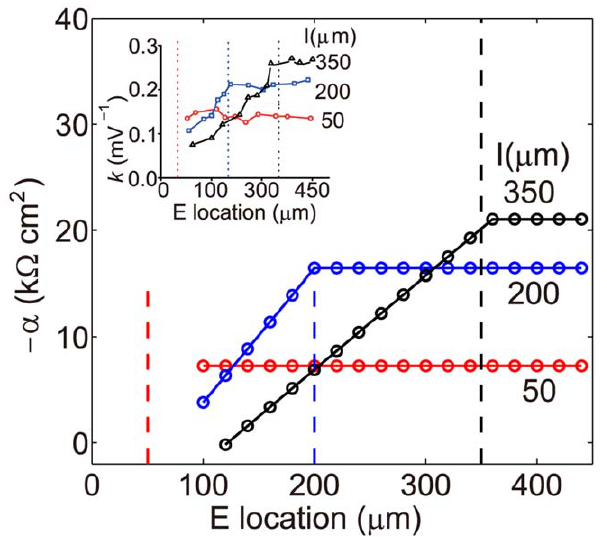
Figure 2. The spatial dependence of { a obtained from Eq. (9). Given three fixed inhibitory input locations, we can parameterize a in Eq. (9) by identifying k M with the shunting coefficient measured in the experiment [20] to obtain the spatial dependence of a . Inset: the experimental measurements of the shunting coefficient [20] as a function of the distance between the excitatory input site and the soma for three fixed inhibitory input sites on the dendrite (marked by dashed lines).